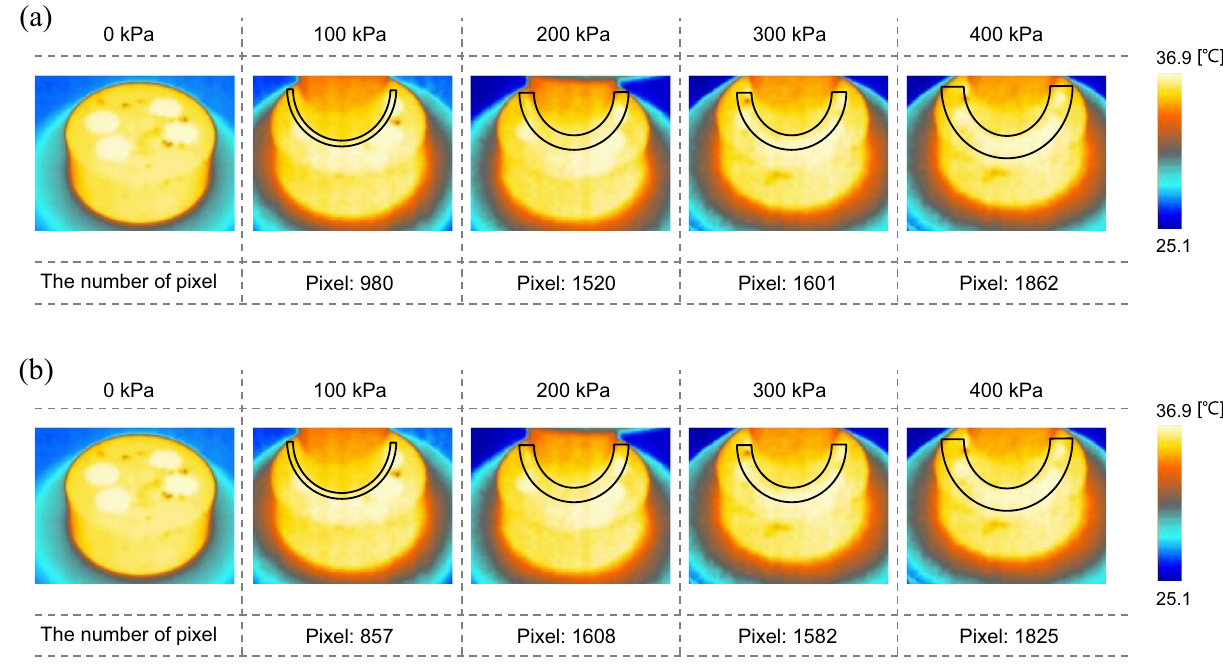
Figure 14. Thermal images measured by the active method through: ( a ) CRI10; ( b ) CRI15. The black box denotes the area of significant